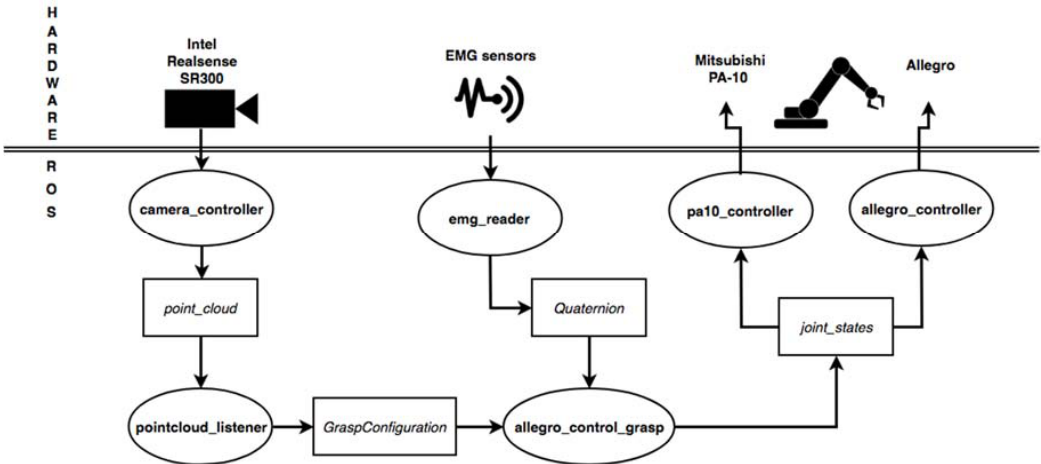
Figure 5. Scheme of the proposed method implemented in Robot Operating System (ROS) showing communication modules among different steps.